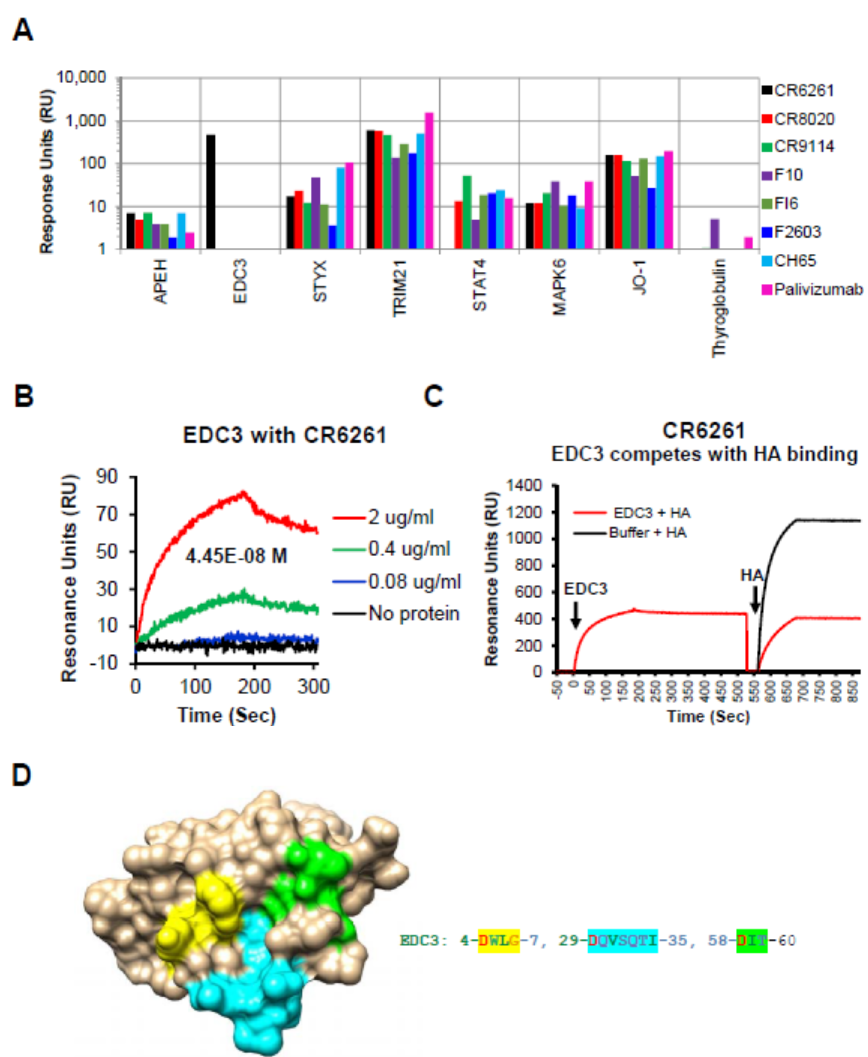
Figure 1. Reactivity of human proteins to bNAbs in Surface plasmon resonance (SPR): EDC3 blocks interaction between CR6261 and recombinant H1-HA. ( A ) SPR assay was performed with the MAbs captured on a protein-G sensor chip followed by addition of recombinant host protein (20 µg/mL) selected using ProtoArray. ( B ) Sensorgrams depicting the reactivity of serial dilutions of recombinant EDC3 in SPR to determine the binding affinity of recombinant EDC3 to the CR6261 by SPR. ( C ) Sensorgram to show competition between EDC3 and HA0 binding to CR6261. The binding of recombinant H1–HA0 (10 µg/mL) to the CR6261 bound EDC3 (10 µg/mL) was measured by SPR. Total H1–HA0 binding to CR6261 in absence of any EDC3 binding was defined as 100%. Percentage inhibition by the EDC3 was determined. ( D ) Structural depiction of potential binding site of CR6261 contact residues on EDC3 (PDB #2vc8). The EDC3 potential binding residue numbers and residues shaded in yellow, cyan, and green shown are depicted in similar colors on the EDC3 structure.